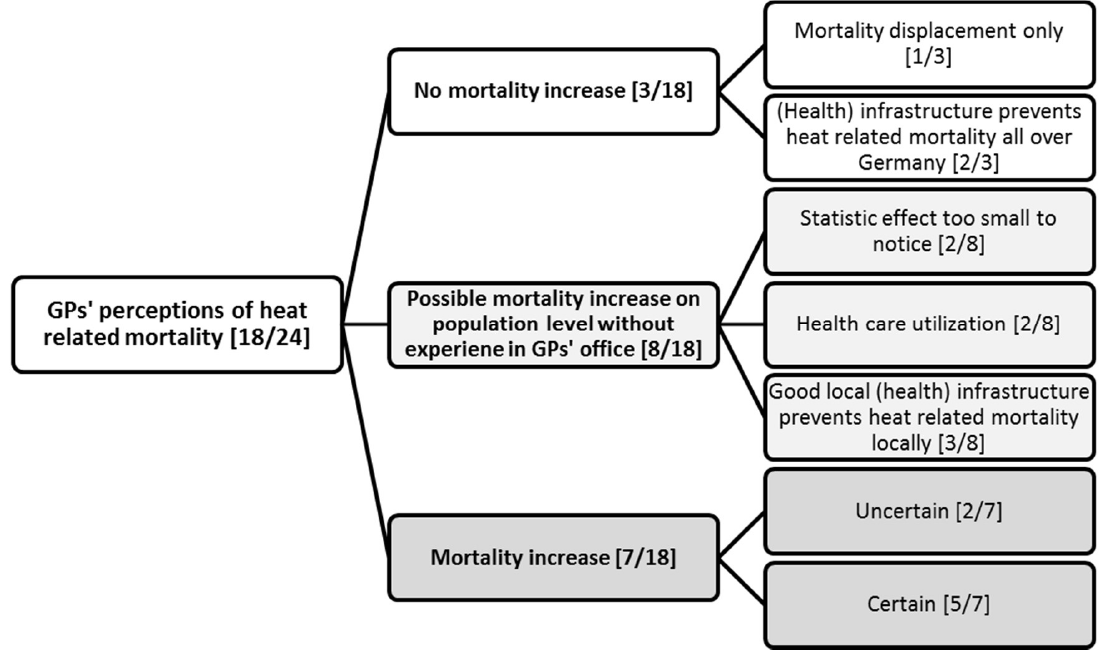
Figure 2. GPs’ perception of heat related mortality.